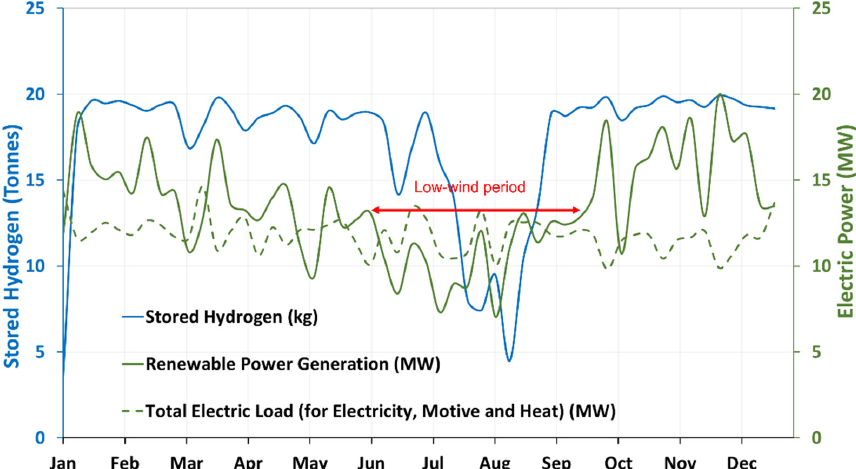
Figure 14. Low-wind period effect on renewable power generation and hydrogen storage level